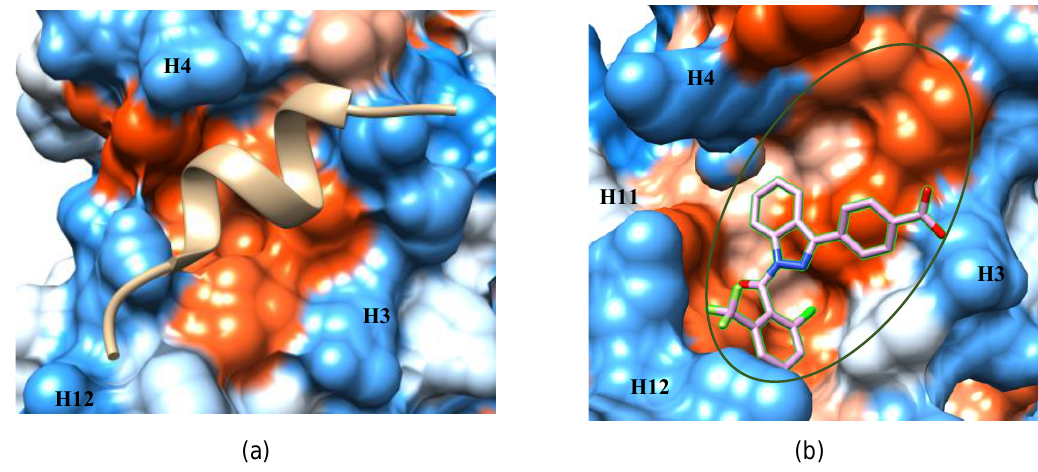
Figure 10. The coactivator-binding pocket (( a ), PDB 3KYT) and the extended AF-2 binding pocket (( b ), PDB 4YPQ). The structure models are presented by hydrophobic surface with red color for high level of hydrophobicity, blue color for high level of hydrophilicity. The extended AF-2 pocket is circled by green line.